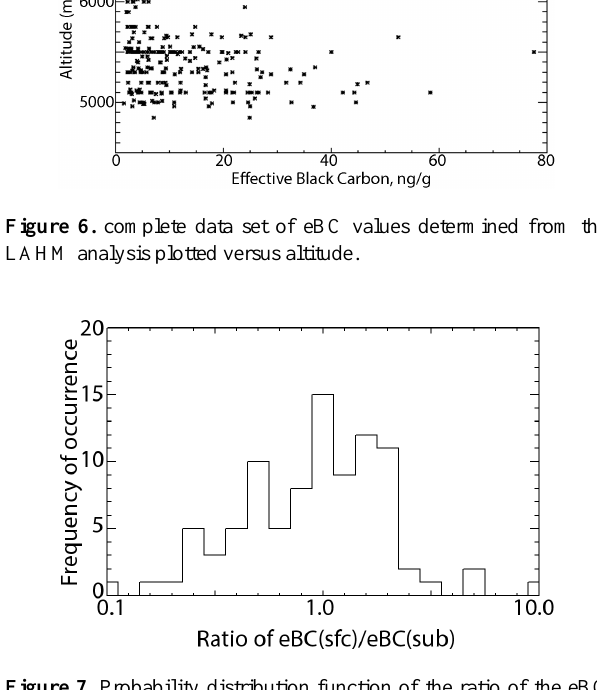
Figure 7. Probability distribution function of the ratio of the eBC value measured for surface samples divided by the eBC value mea- sured for subsurface samples presented. x axis is on a log scale and bins are logarithmically spaced.